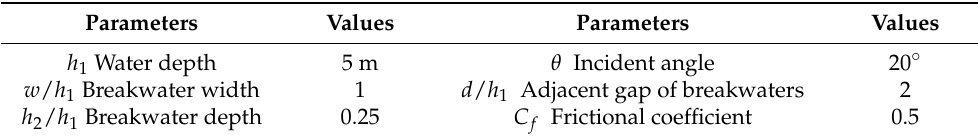
Table 1. Numerical data employed for computation.